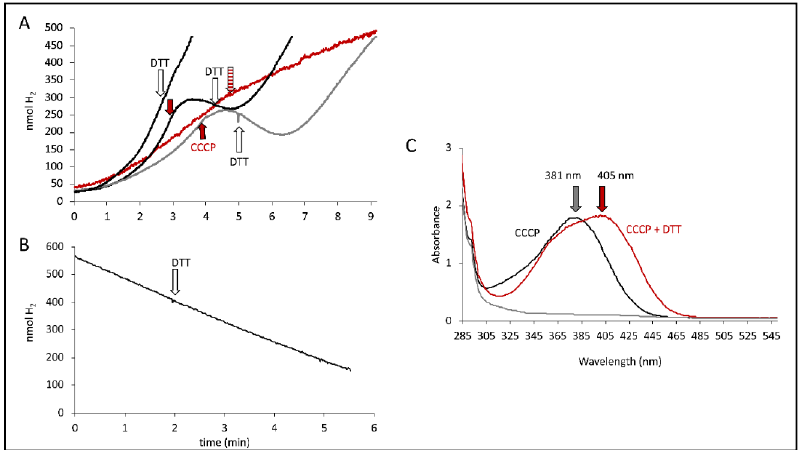
Figure 5. DTT effect. ( A ) Electrode traces of MC4100 cells producing H 2 from either glucose (grey curves) or formate (black curves). CCCP addition (red arrow, 100 µM) and DTT addition (white arrow, 5 mM) are indicated. The red trace shows the combined addition of DTT and CCCP (striped red arrow). ( B ) Electrode trace of strain HDK103 (Δ hyaB Δ hycA-I ) showing the activity of Hyd-2 as H 2 oxidation of H 2 -saturated buffer after the addition of 15 mM fumarate. The white arrow indicates the addition of 5 mM DTT. ( C ) Absorption spectra of CCCP solution (black), CCCP solution after DTT addition (red) and DTT alone (grey). The arrows indicate the respective maxima.